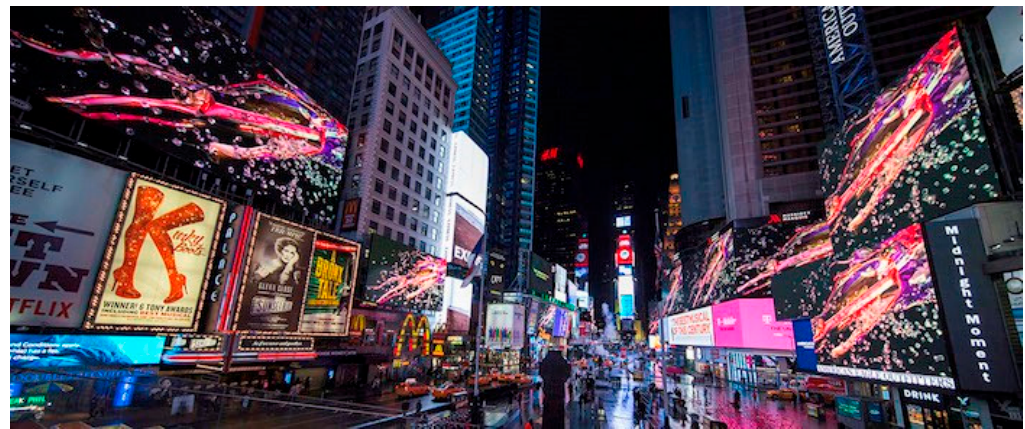
Figure 11. Sound of Ikebana exhibited in Times Square, New York.